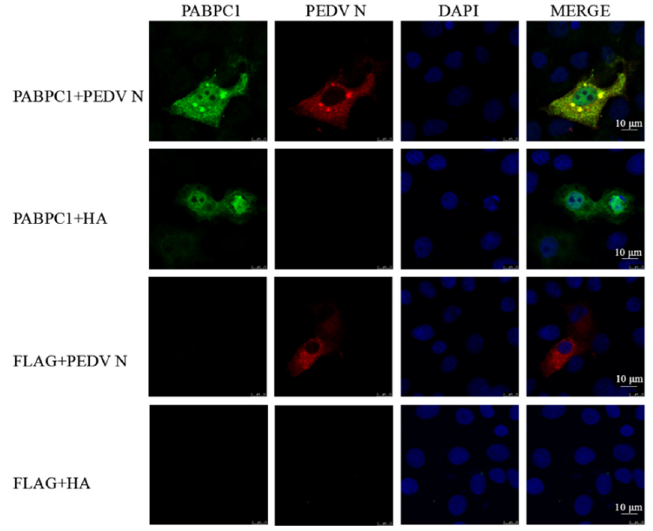
Figure 5. Co-location of PABPC1 and N protein. The scale bars indicate 10